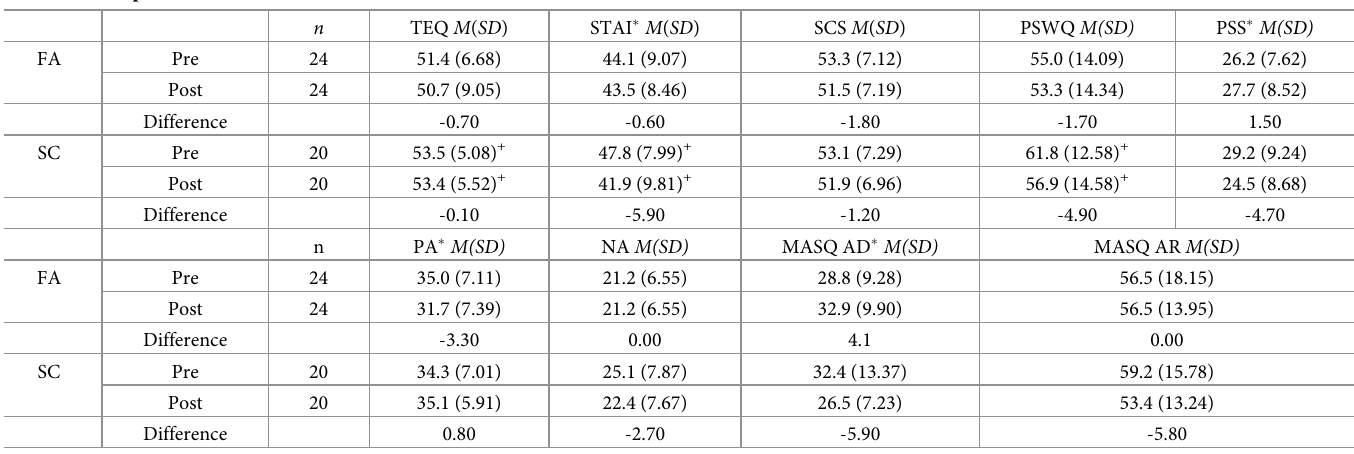
Table 2. Self-report